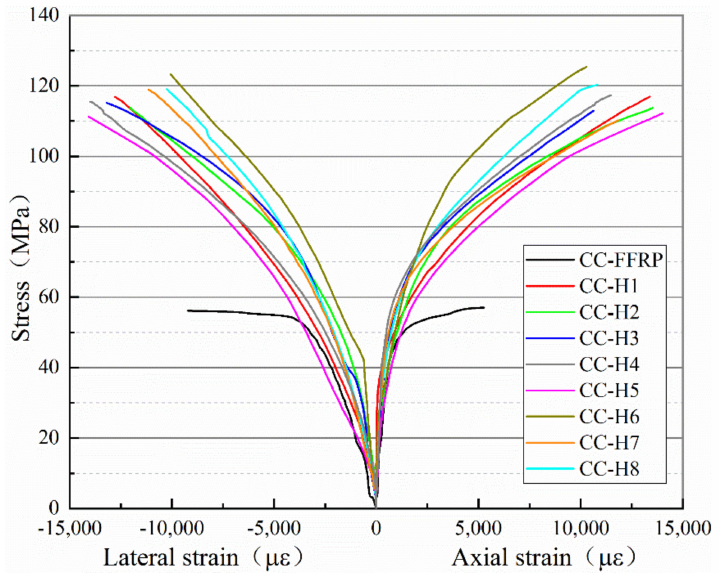
Figure 7. Stress–strain curve relationship of concrete cylinders under unconstrained and different constraint conditions.